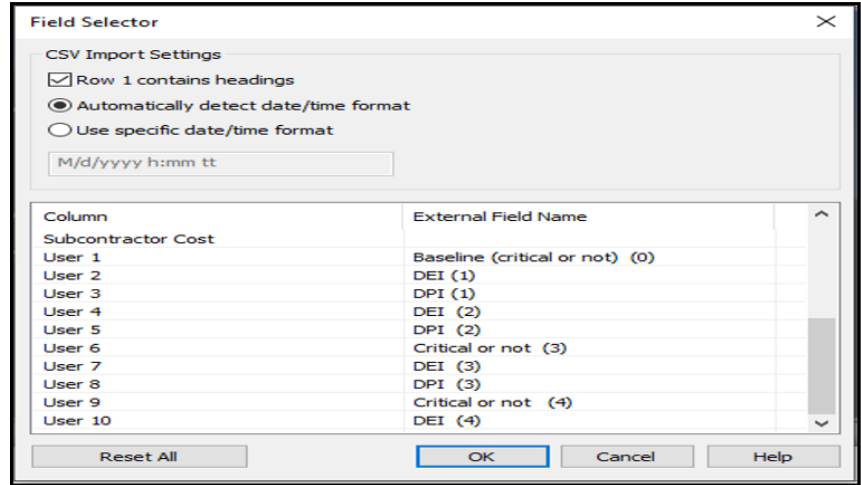
Figure 8. Adjustment of columns headings.